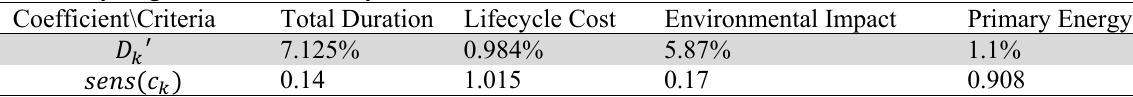
Criticality degrees and sensitivity coefficients of attributes